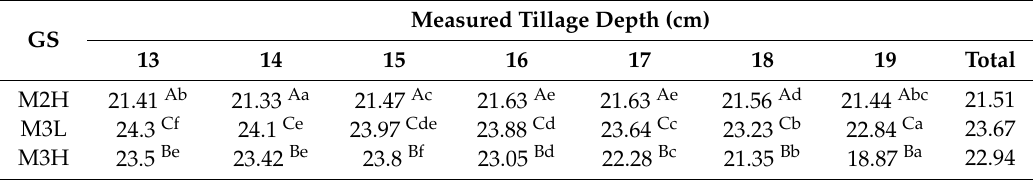
Table 14. Mean rear axle rotational speed (rpm) according to tillage depth and gear selection.